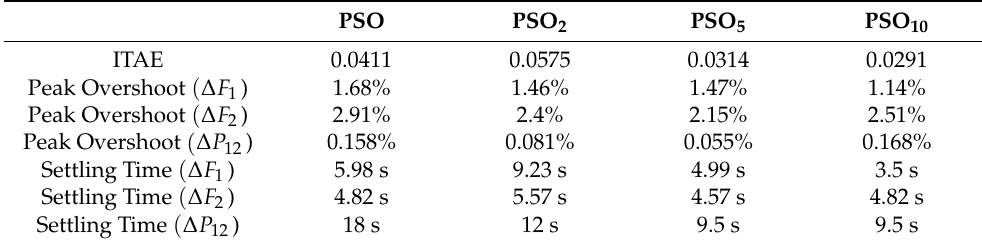
Table 4. Key performance parameters for the LFC of the test system pertaining to case study-I with PSO, PSO 2 , PSO 5, and PSO 10 .